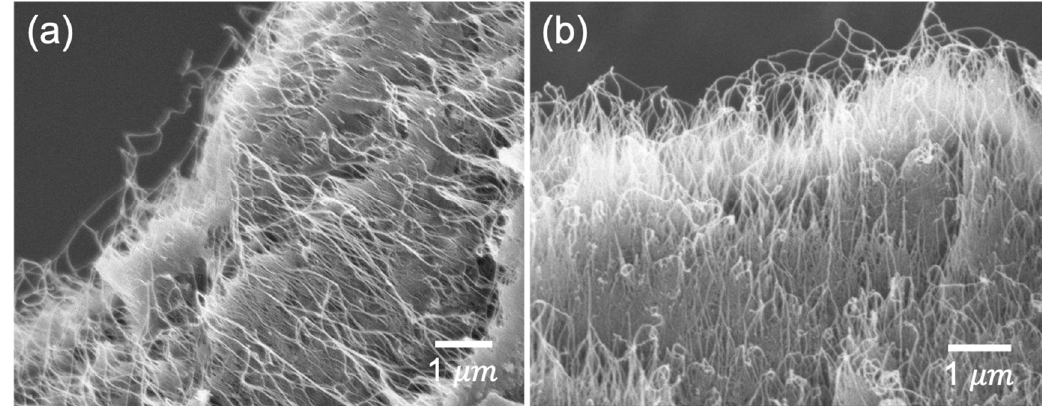
Figure 6. Typical scanning electron micrographs of PPE/SWNT nanocomposites containing 50 wt% SWNTs. ( a ) PPEC8/SWNT and ( b ) PPEOC8/SWNT. The SWNTs are shown as entangled nanofibrils in the polymer matrix.